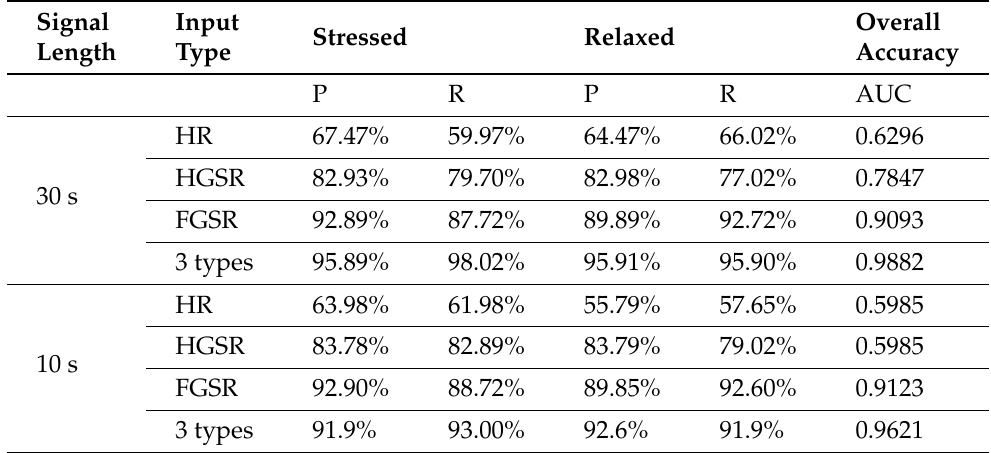
Table 7. Performance of the suggested method’s classification depending on input signal duration and sensor